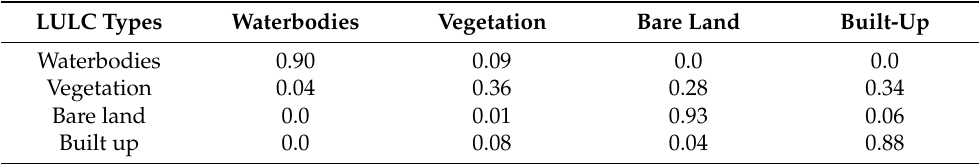
Table 2. Transitional probability matrix of different land use/land covers in Rangamati municipality from 2008 to 2018.